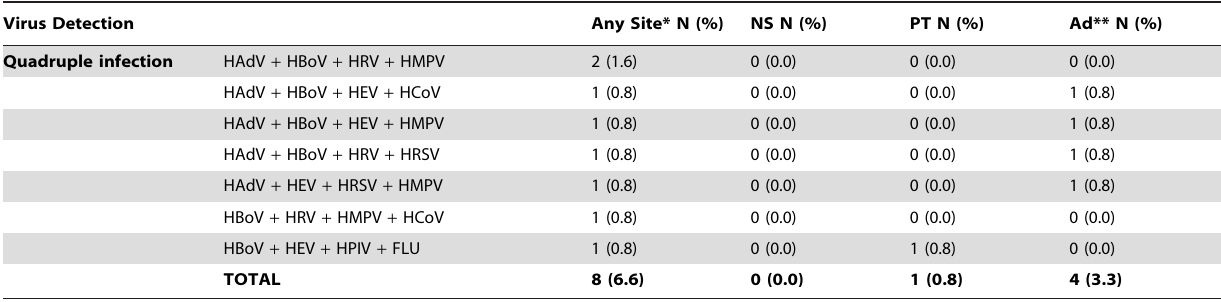
Virus Detection